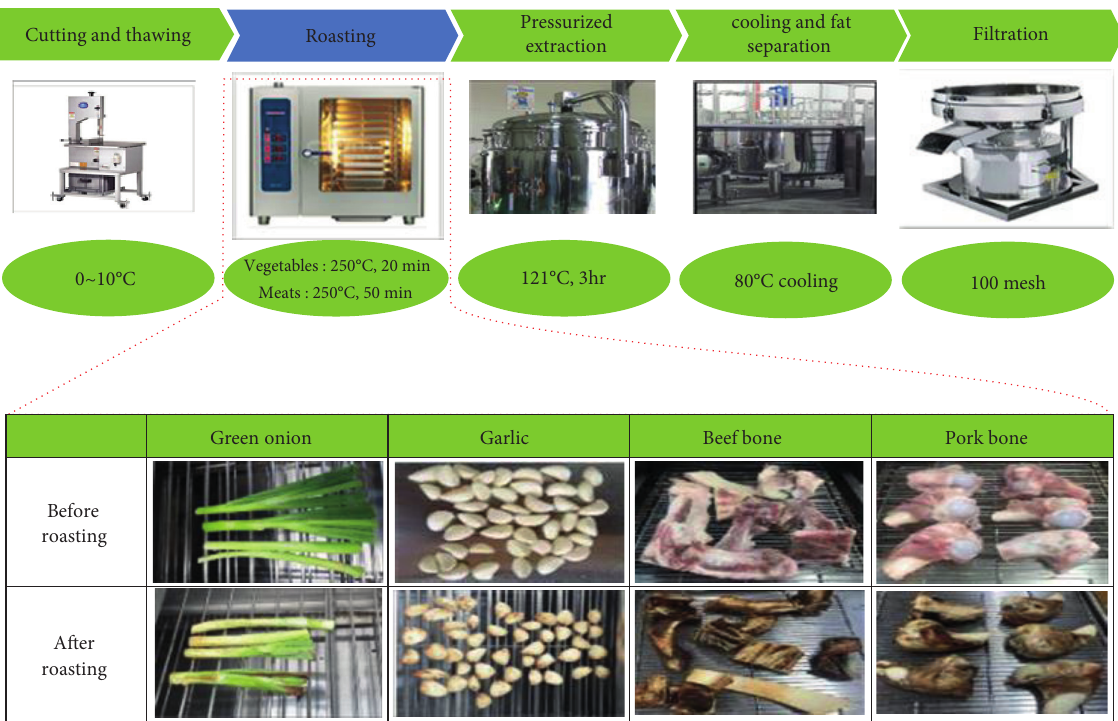
Figure 1: Process and change in raw materials by convection heated